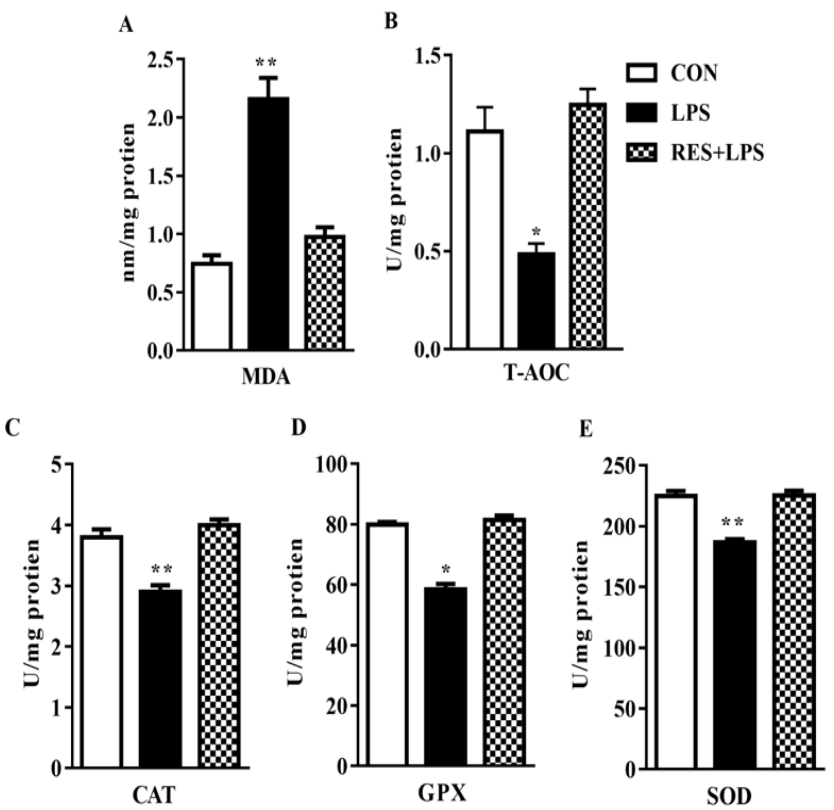
Figure 2. The effect of resveratrol on antioxidant enzyme activity and total antioxidant capacity ( A ) Malondialdehyde (MDA) ( B ), Total Antioxidants (T-AOC) ( C ), Catalase (CAT) ( D ), Glutathione Peroxidase (GPX) and ( E ) Superoxide Dismutase (SOD) enzyme activities in the mammary tissue of female mice. * p < 0.05 significant and ** p < 0.005 highly significant.